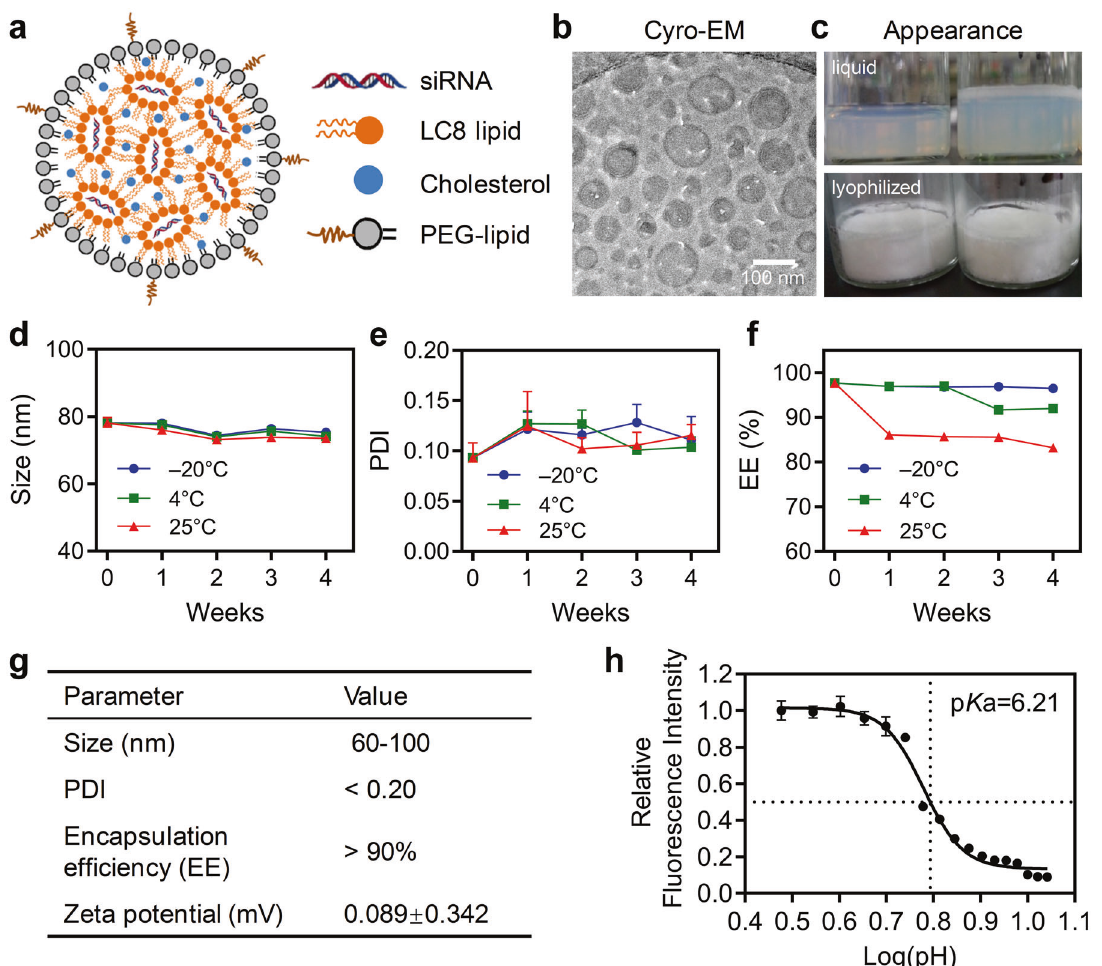
Fig. 1 Characteristics of RBP131/siRNA nanoparticles. a Schematic illustration of RBP131/siRNA nanoparticle and the compositions. b Cryo-EM image of RBP131/siRNA nanoparticles. c Appearance of liquid and lyophilized RBP131/siRNA formulations. d – f Particle size ( d ), polydispersity index (PDI) ( e ), and encapsulation ef fi ciency ( f ) changes when RBP131/siRNA was kept at − 20 °C, 4 °C, 25 °C for 1, 2, 3 and 4 weeks, respectively. g Primary quality speci fi cations of RBP131/siRNA formulation. h p K a titration of RBP131/siRNA